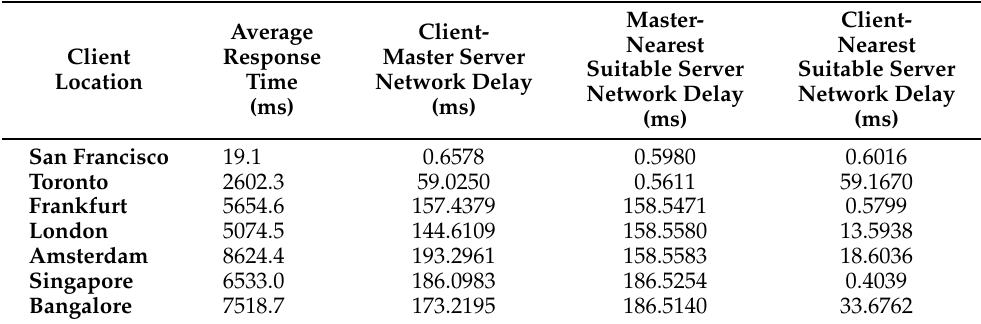
Table 18. Average response time and network delay of third